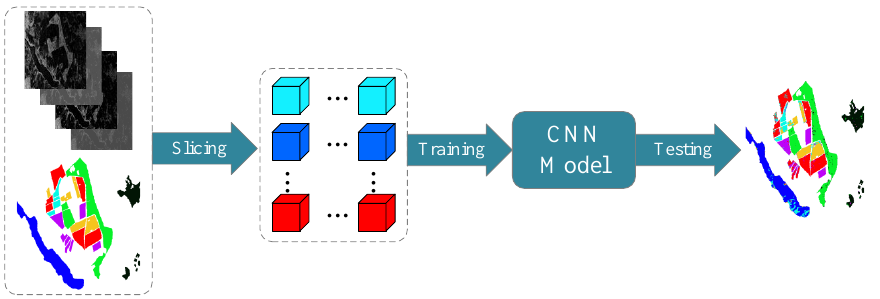
Figure 5. General flow chart of the CNNs-based PolSAR images classification